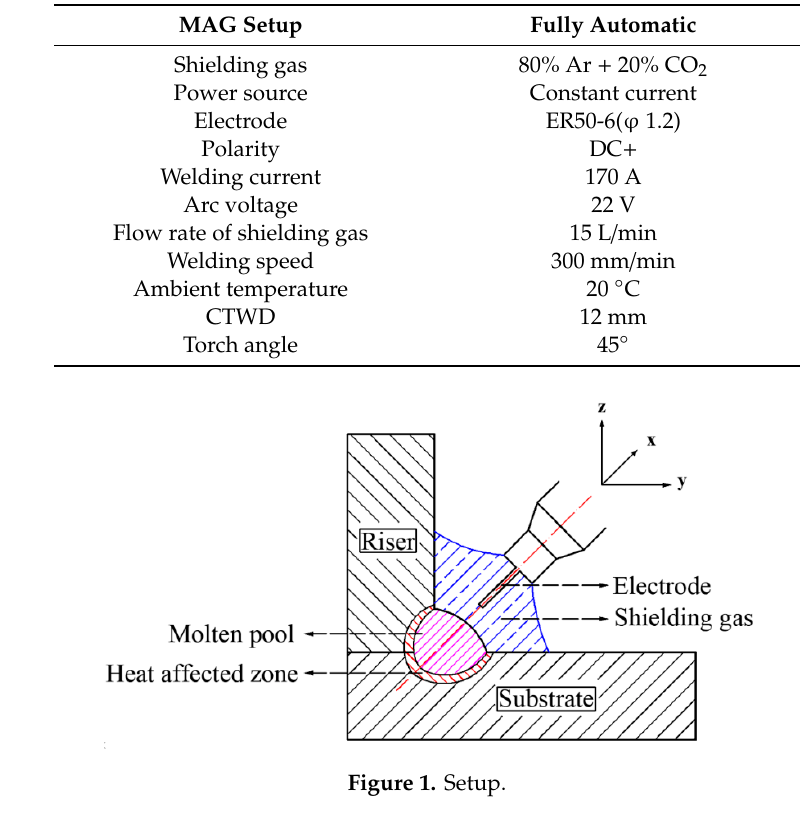
Table 2. Welding parameters.